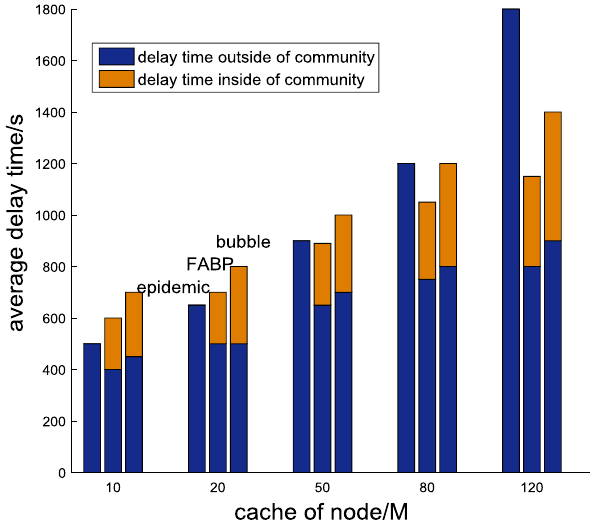
Figure 9. Comparison of the average latency time under different caches.